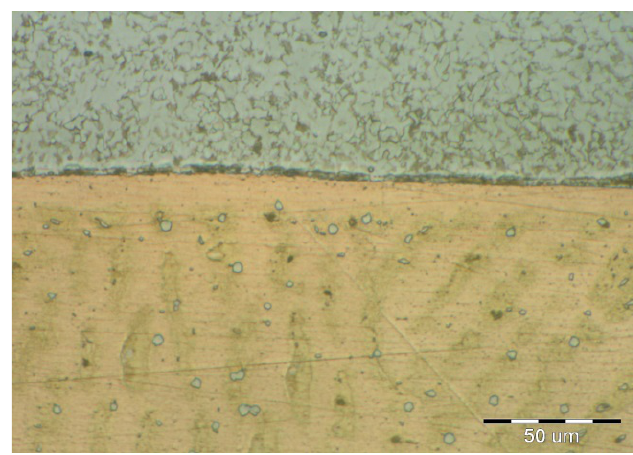
Figure 9. Interface between cladding and BM (base material).